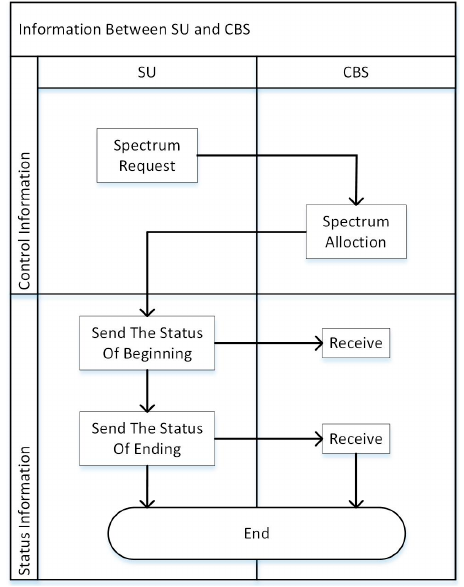
Figure 2. Schematic diagram of the data interaction between the secondary user (SU) and the central base station (CBS).